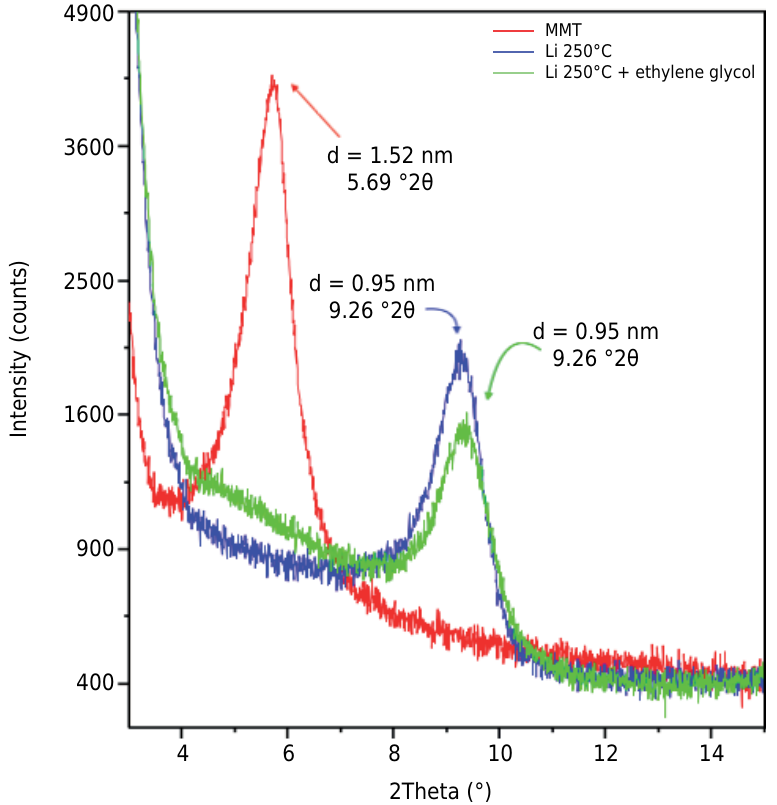
Figure 5. XRD of the natural montmorillonite sample submitted to the Greene Kelly test.